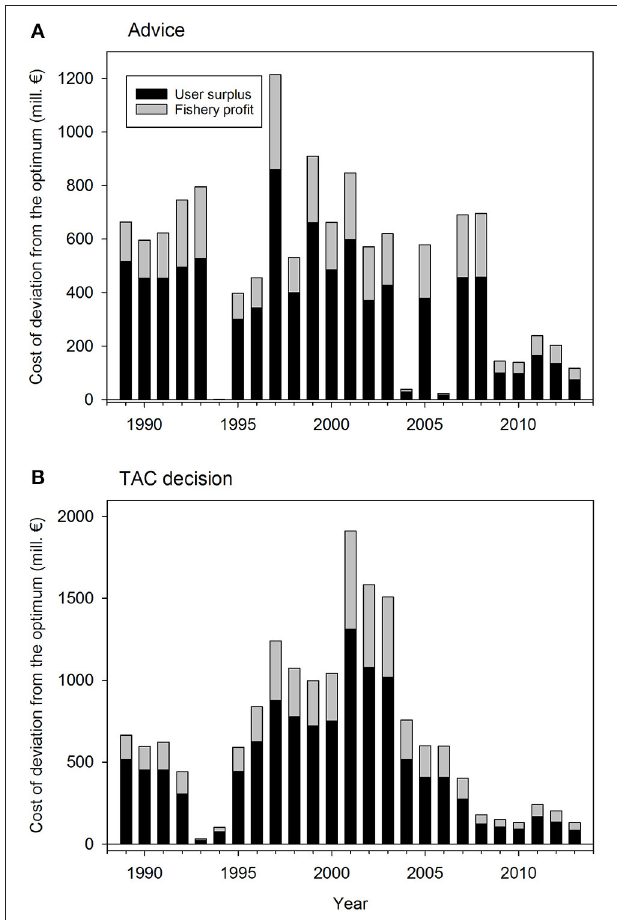
FIGURE 2 | Economic costs of deviating from advice: time-series 1989–2013. Costs arising when following standard scientific advice (A) or when following political TAC decisions (B)